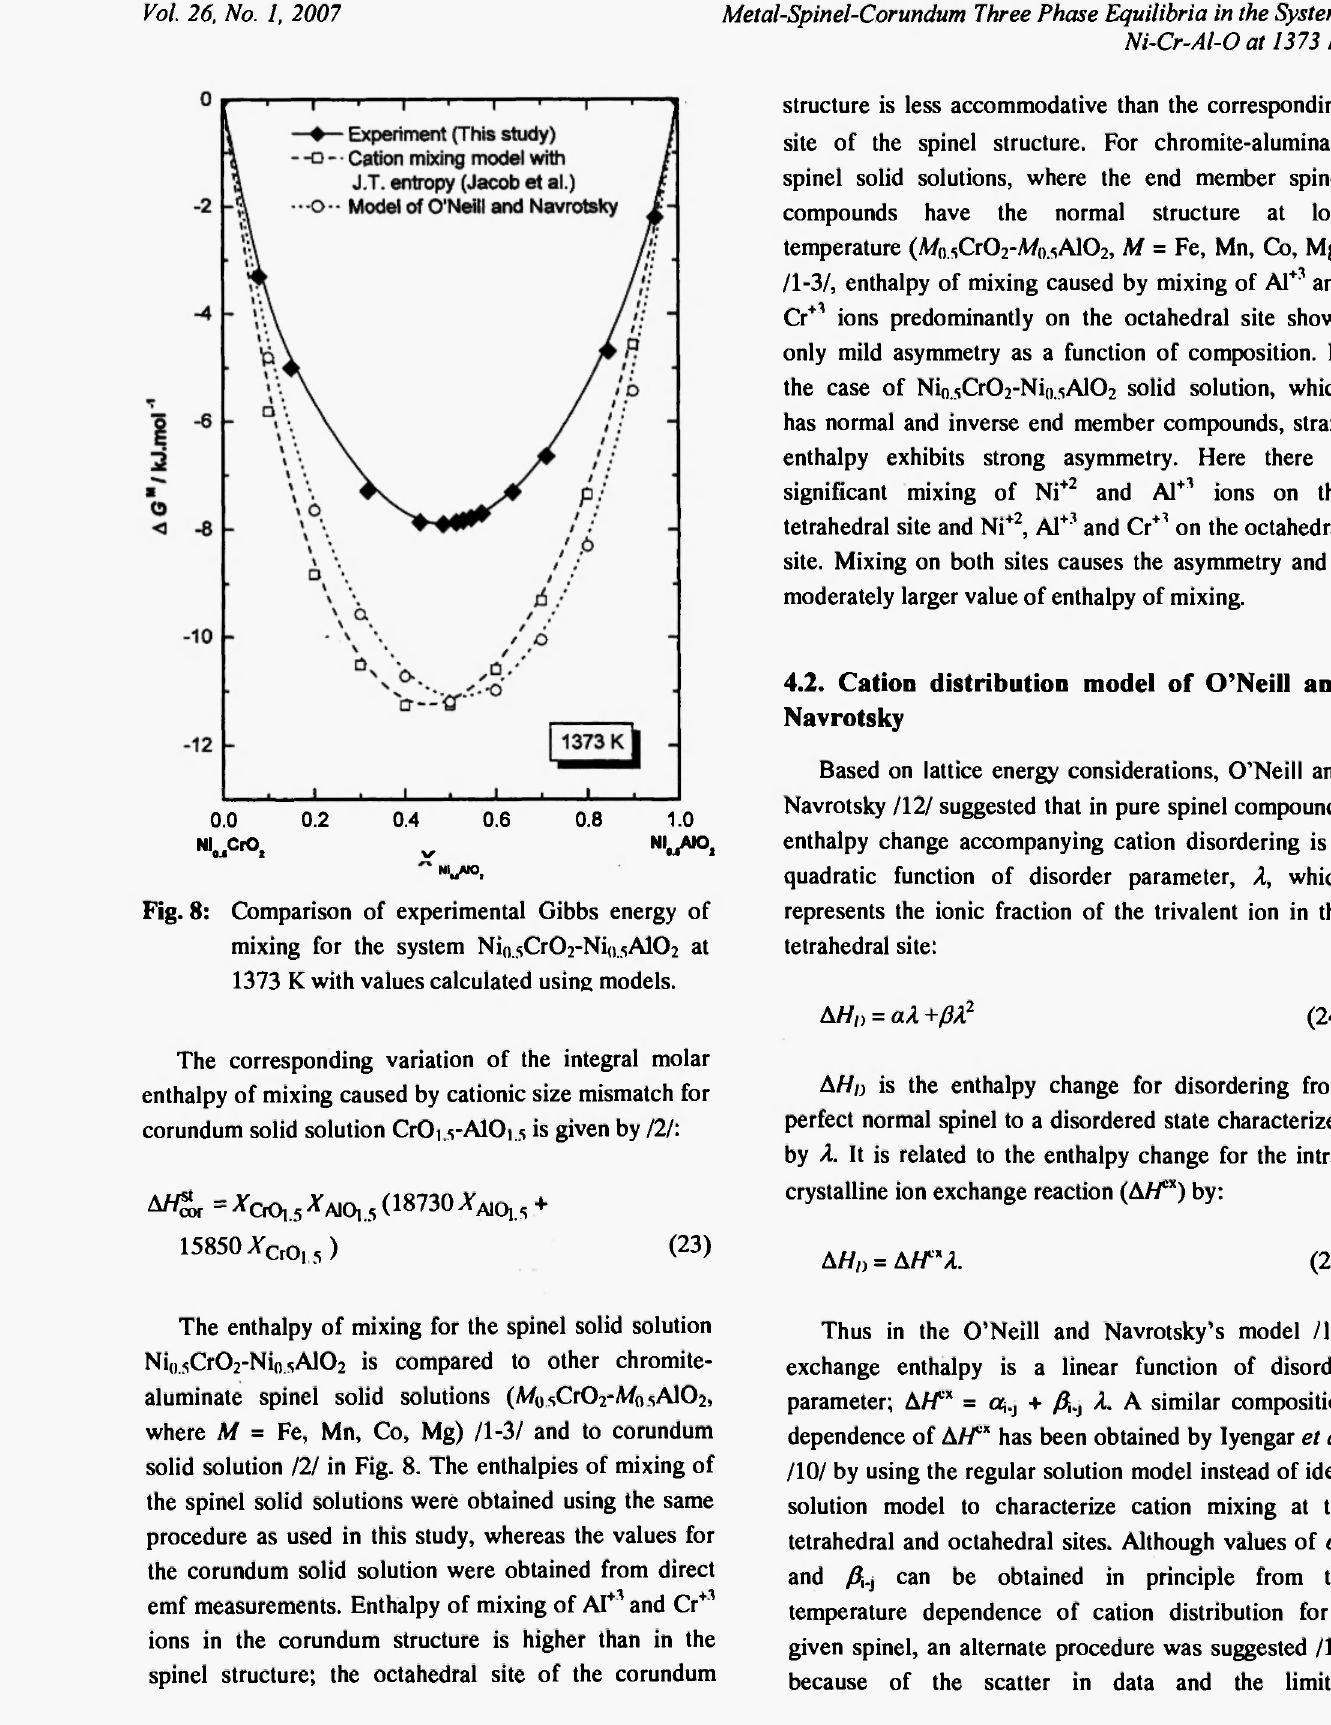
-Ni<) A10 at 5 2 0 .5CrO 2